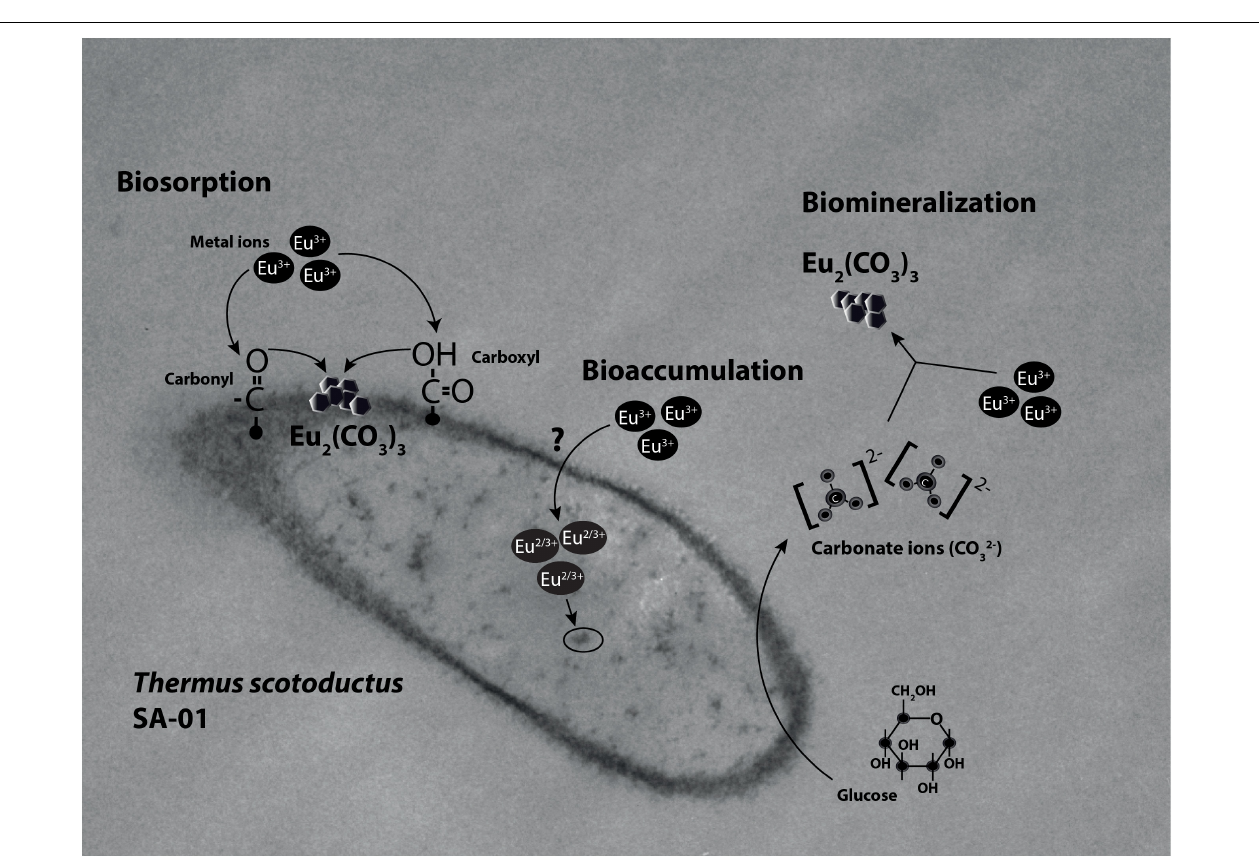
involved in metal accumulation and detoxification in bacteria (Rao and Kornberg, 1996; Kuroda et al., 1999; Nikel et al., 2013) as a defense mechanism against environmental stress.